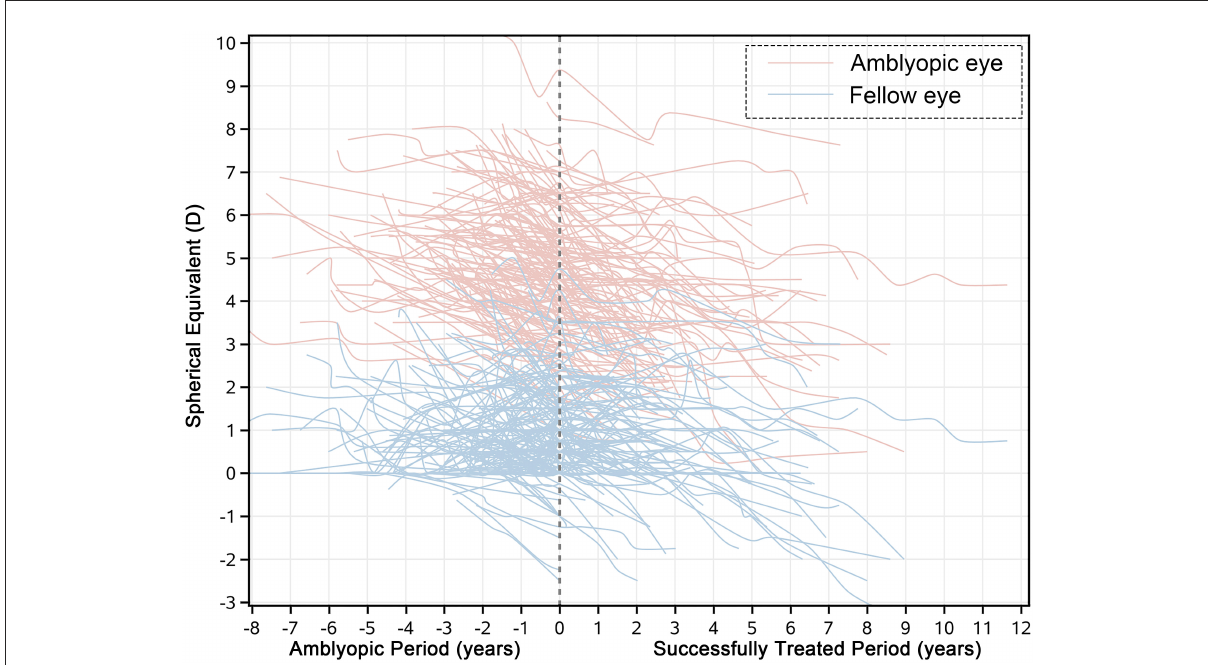
FIGURE4 The illustration of refractive development patterns for the amblyopic period and the amblyopia resolved period. The dashed line represents the timepoint when the amblyopes were treated successfully. The light red line represents the original SE of the amblyopic eye and the light blue line represents the original SE of the fellow